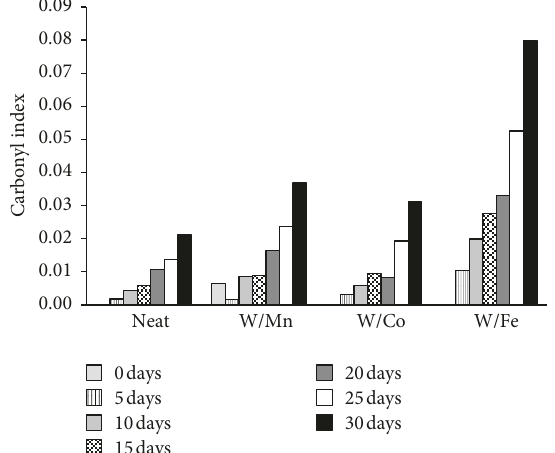
Figure 9: Stress-strain curve for the Apel 6509 resin with Fe